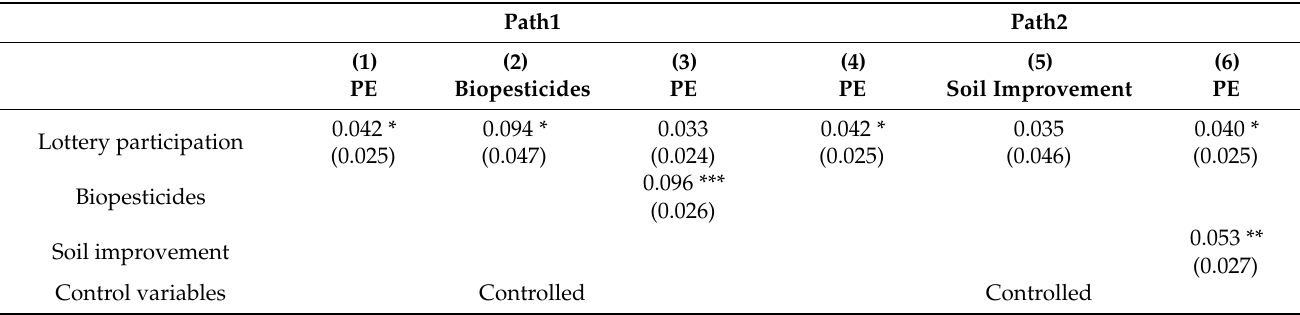
Table 8. Results of the mediating